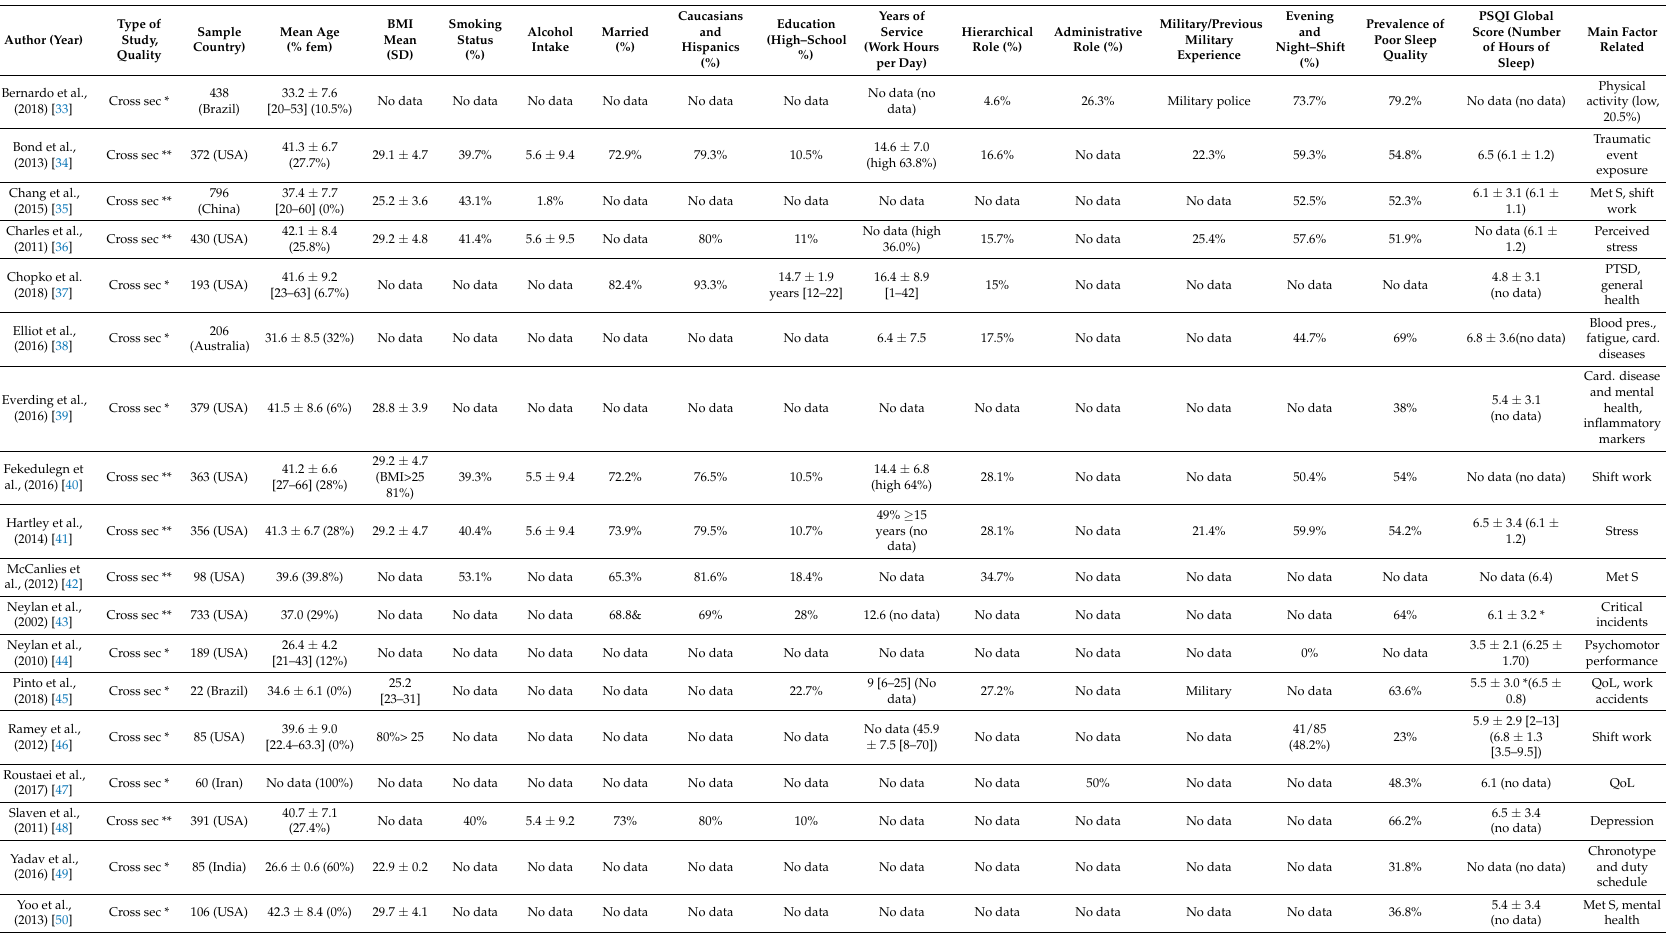
Table 1. Characteristics of the studies included in the present systematic review and